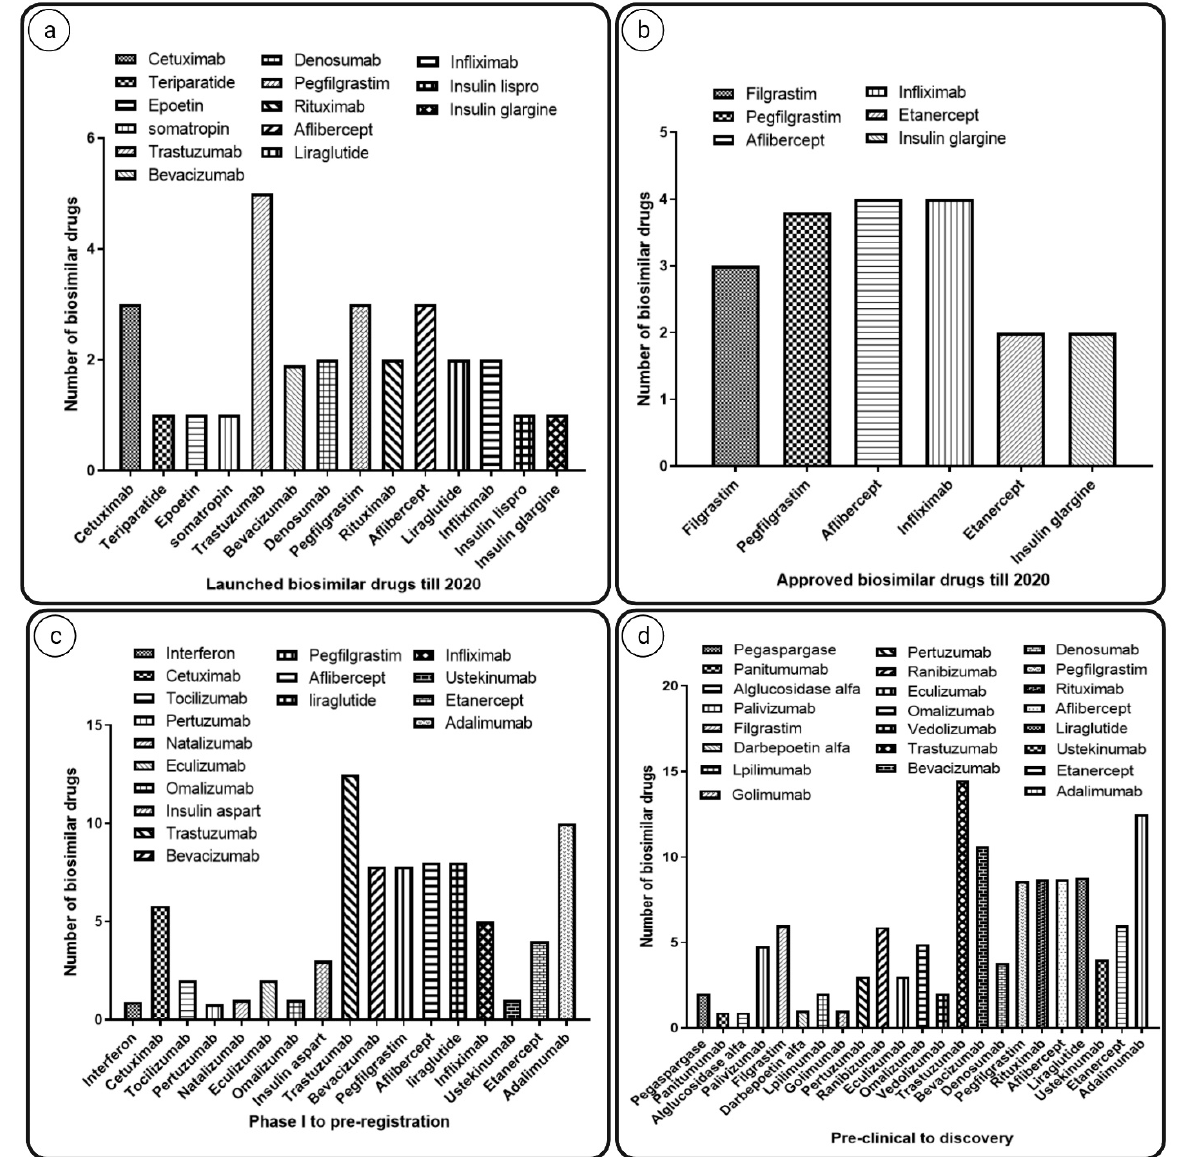
Figure 3. Biosimilars launched, approved, or in development. The graphs indicate number of ( a )